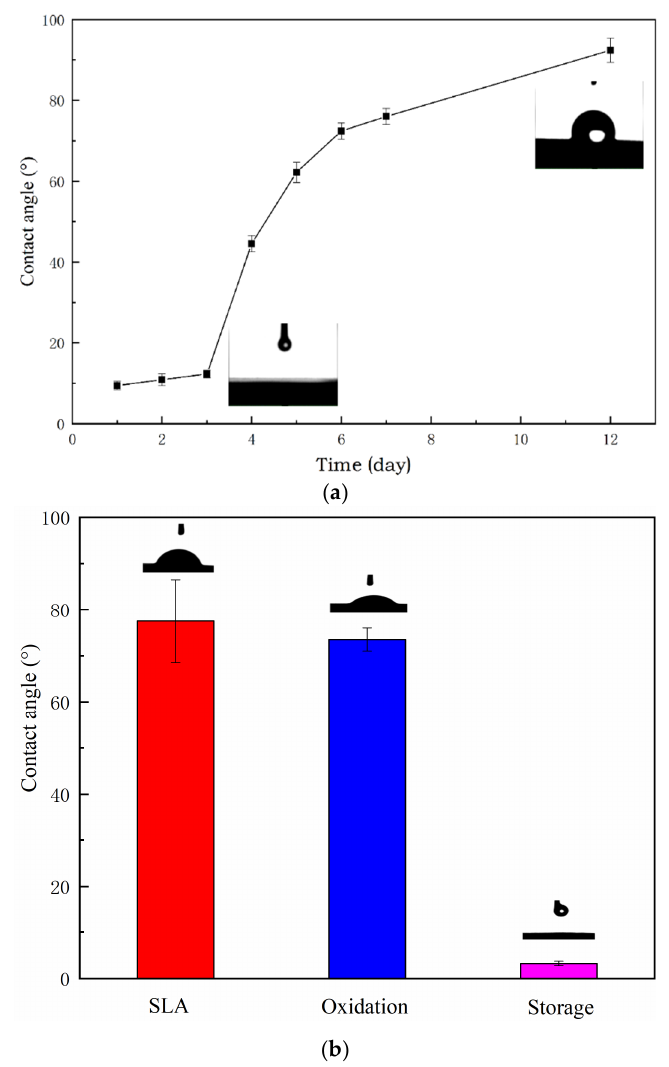
Figure 4. ( a ) Hydrophilic changes in the oxidized surface over time. ( b )The contact angles of the three groups.